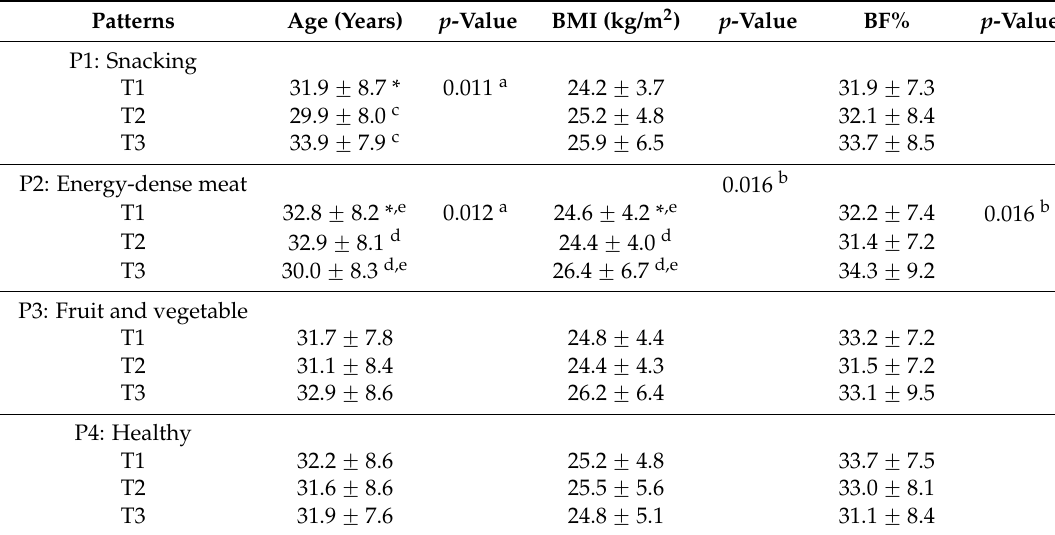
Table 3. Associations between dietary patterns and age, body mass index (BMI) and body fat percentage (BF%) in NZE women, aged 16–45 years ( n =